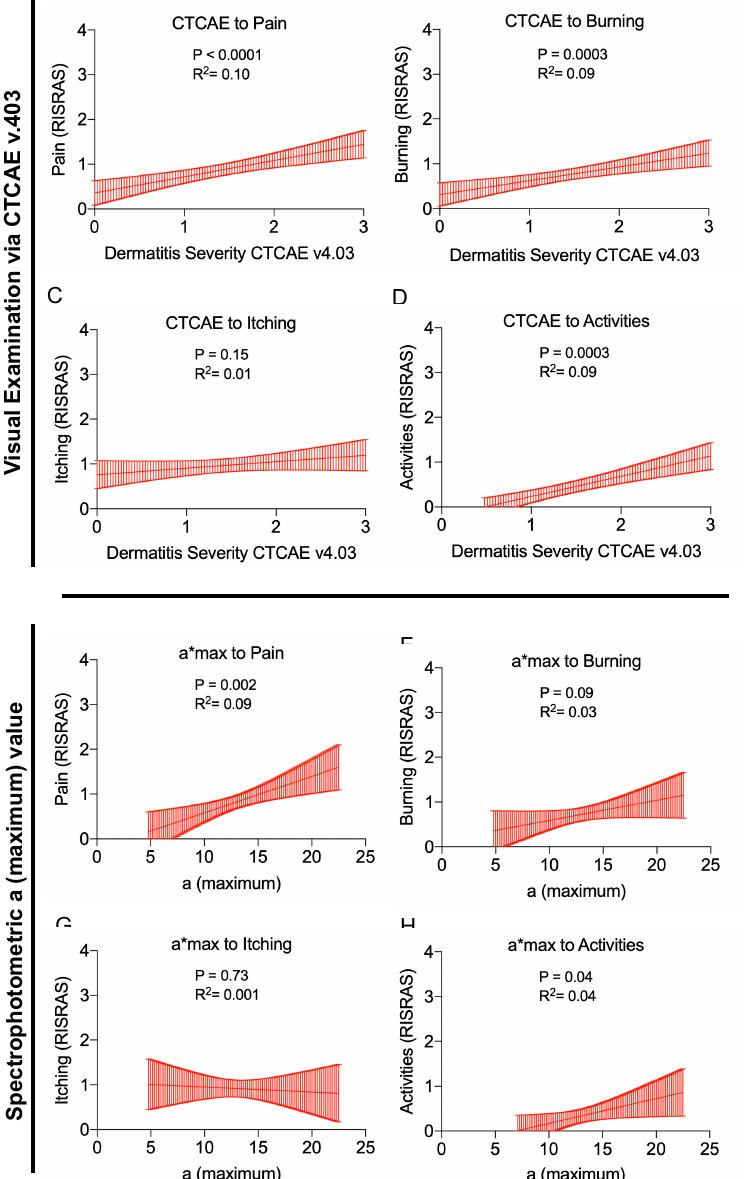
Figure 5. Correlations between RID severity and subjective symptoms. Straight red lines indicate the simple linear regressions, red shaded areas represent the 95% confidentiality intervals. The goodness of fit R 2 and statistical slope deviance from zero ( p values) are provided within each graph. ( A – D ) depict individual symptoms (RISRAS) correlated with physician-assessed CTCAE gradings. ( E – H ) Correlation of maximum a* values with patient-assessed RISRAS scores. ( A + E ) Pain of the irradiated skin area. ( B + F ) Burning sensation of the radiated skin area. ( C + G ) Itching sensation of the radiated skin area. ( D + H ) Reduction of everyday life activities due to